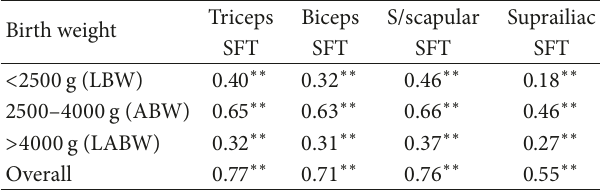
shows this graphically. The correlation matrices for birth weight categories and skinfold measurement are shown in Table 6. The correlation coefficients between birth weight category < 2500 g (LBW) and skinfold measurements ranged from 0.18 to 0.46 while that of birth weight category 2500–4000 g (ABW) and skin- fold measurement ranged from 0.46 to 0.66. The correlation coefficient between birth weight category > 4000 g